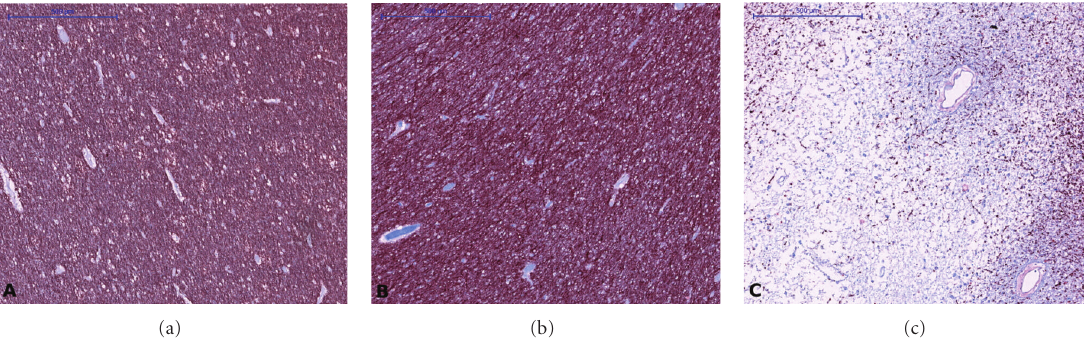
Figure 2: Tissue sections immuno-stained against MBP representing healthy WM (a), NAWM (b), and a demyelinated WM lesion (c). Bar = 500 μ m.